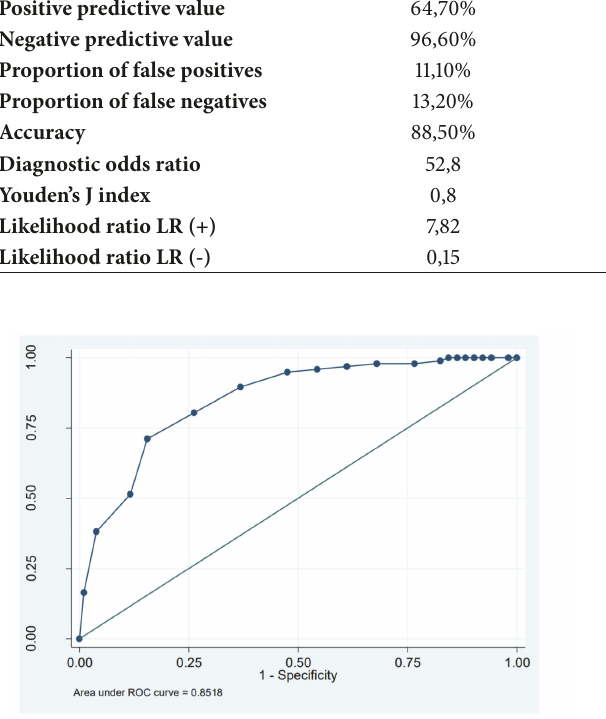
Figure 1: ROC curve and value of correct classification